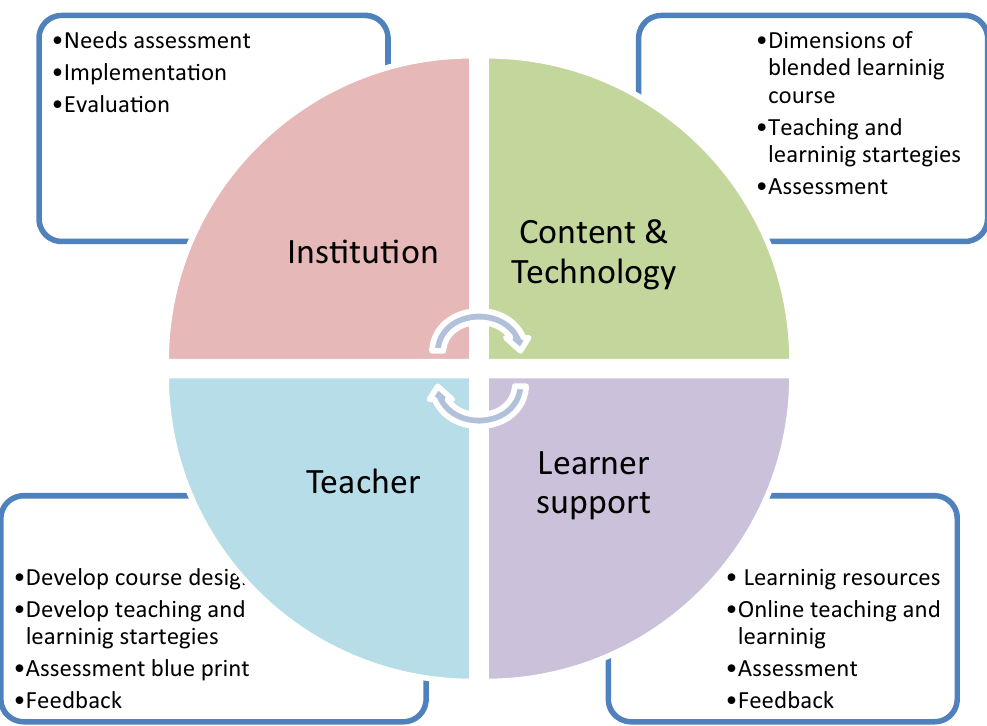
Figure 1. Guidelines for blended learning based on the complex adapted blended learning system (CABLS) framework.